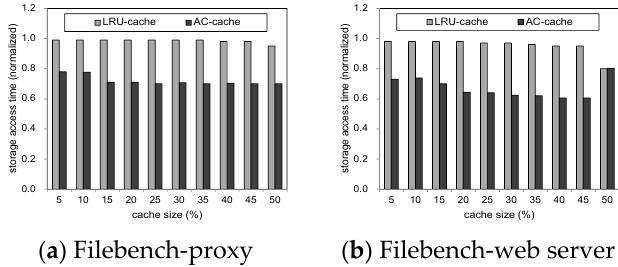
Figure 7. Performance comparison of the buffer cache with Least Recently Used (LRU) and Figure 6. Performance effects of the buffer cache when storage is the RAMDisk. admission-controlled LRU when storage is the RAMDisk.